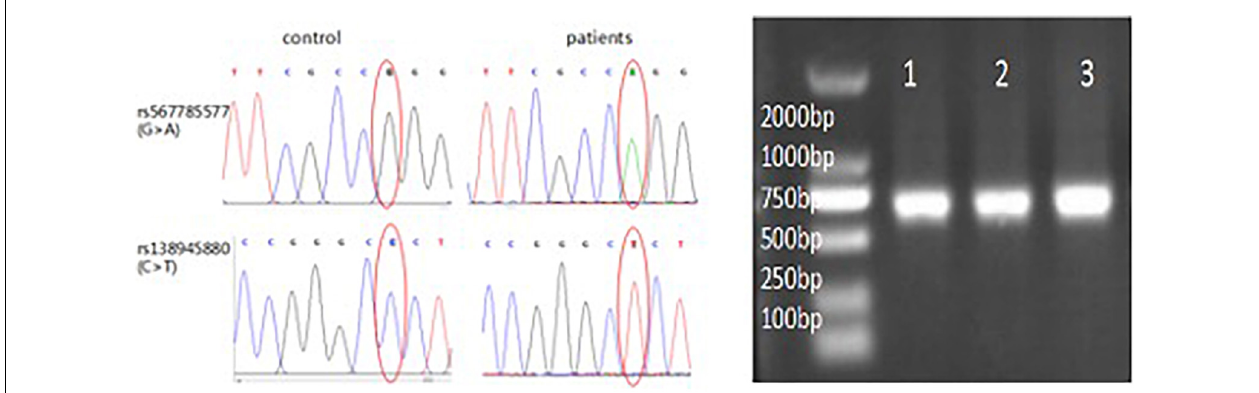
FIGURE 4 | Homozygosity of LGALS7 SNP alleles in patients with ICH. LGALS7 gene sequencing electropherogram showing sequences in regions of SNPs rs567785577 and rs138945880. Right figure: results show successful insertion of promoter region DNA of the LGALS7 gene into the vector (750 bp). Results of electrophoresis of PCR products revealed predicted results for the patients with ICH (lane 1) and two control healthy subjects (lanes 2–3), respectively.